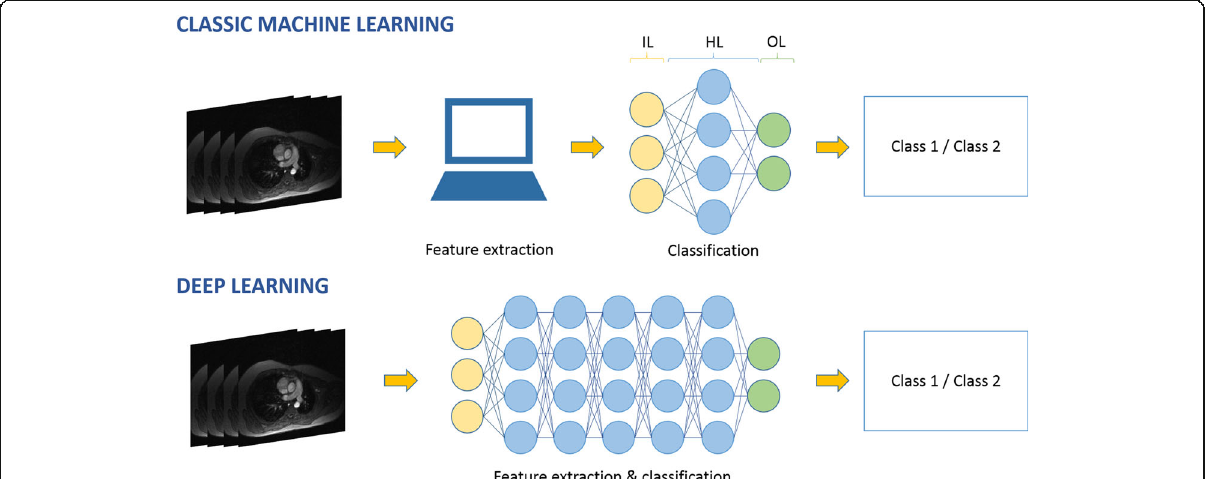
Fig. 2 Comparison between classic machine learning and deep learning approaches applied to a classification task. Both depicted approaches use an artificial neural network organised in different layers ( IL input layer, HL hidden layer, OL output layer). The deep learning approach avoids the design of dedicated feature extractors by using a deep neural network that represents complex features as a composition of simpler ones